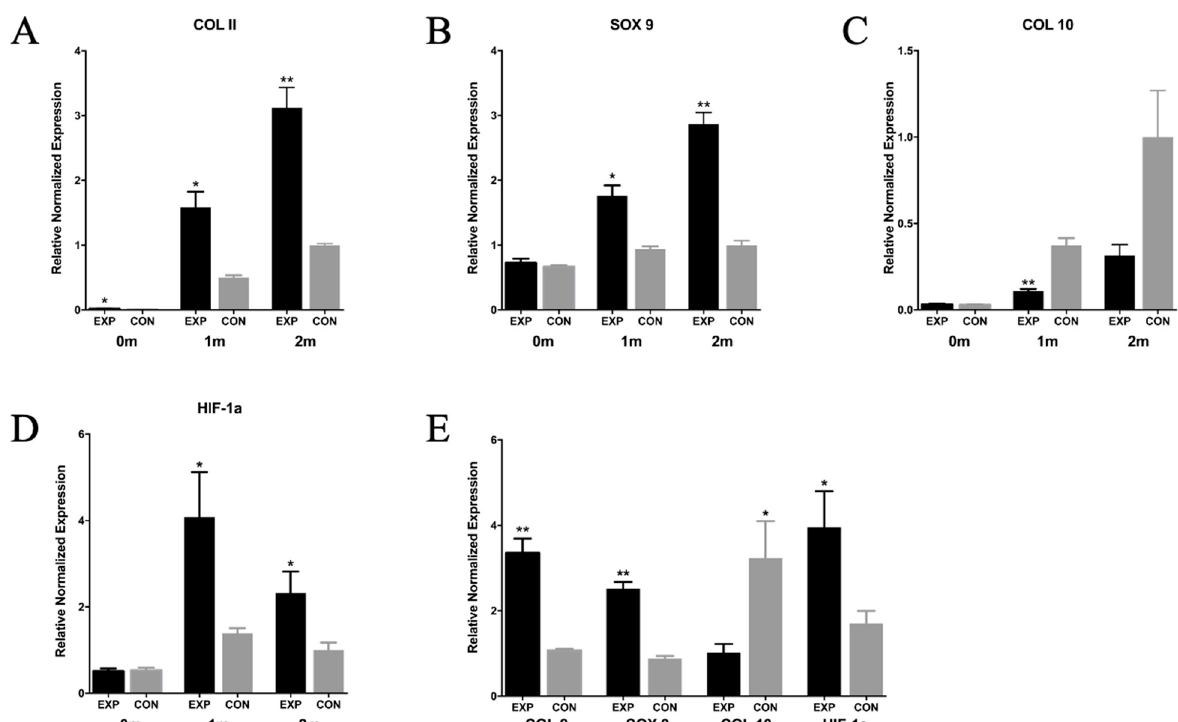
Figure 7. The quantitative gene expression by real-time PCR of the EXP group, the CON group and the N-C group in vivo. ( A – D ) The expression of Col2A1, Sox-9, Col10A1, and HIF-1a of EXP group and CON group before implantation, 1 month and 2 months after implantation. Gapdh was used as reference gene. ( E ) The expression of Col2A1, Sox-9, Col10A1, and HIF-1a of EXP group and CON group at 2 months after implantation, in which the expression of Col2A1, Sox 9, Col10A1 and HIF-1a in natural cartilage was used as reference, respectively. (n = 3, * p < 0.05, ** p < 0.01.)